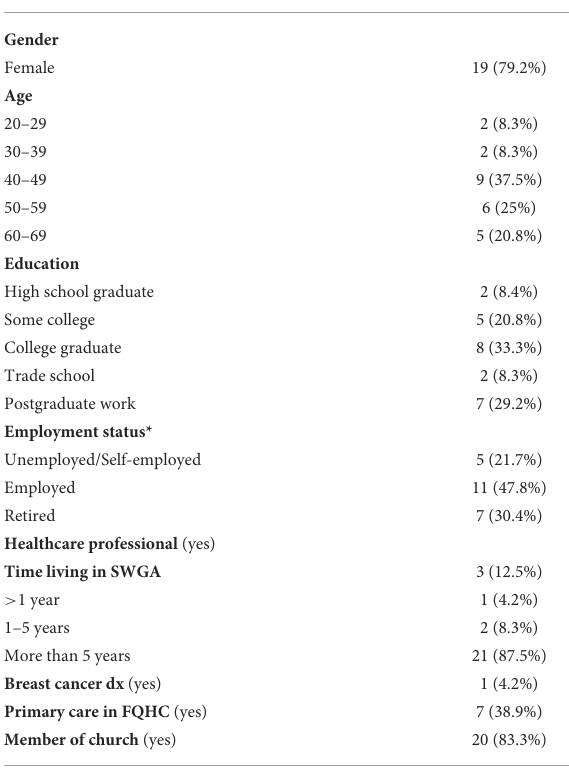
TABLE 2 Participant characteristics reflecting viewpoints diversity ( N =